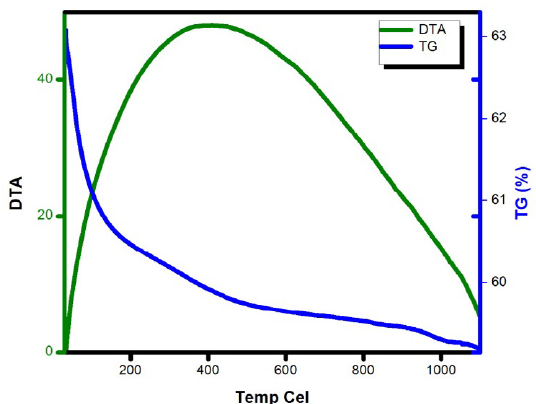
Fig. 9. TG / DTA curve of ZrO2 nanoparticles